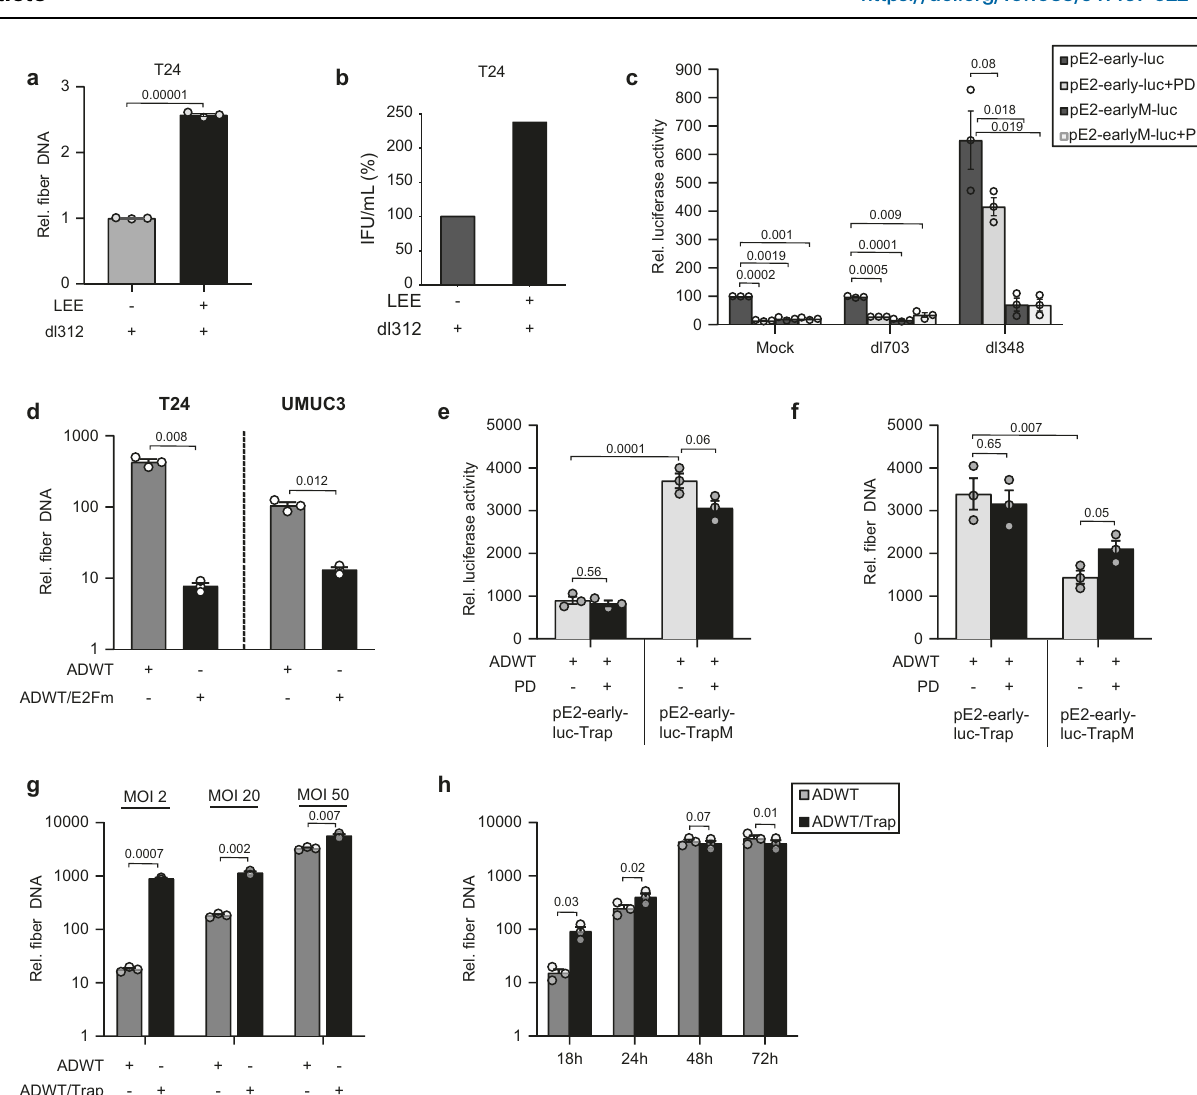
containing 10 E2-earlymotifs with 20E2Fbinding sites (pE2-early-luc-Trap) or with mutated E2F binding sites (pE2-early-luc-TrapM). Cells were infected with ADWT (MOI 50). Luciferase activity ( e ) (mean±SE) and viral replication ( f ) were assessed at 24hpi, n =3. g Viral genome replication was analyzed at 24hpi in T24 cells infected with ADWT or ADWT/Trap at indicated MOI, n =3. h T24 cells were infected with ADWT or ADWT/Trap (MOI 10) and viral genome replication was analyzed at indicated time points, n =3. All the viral replication analyses were performedbyqPCRtoamplifyviral fi berDNA.Dataarerepresentedasrelative fi ber compared to fi ber DNA at 4hpi as baseline ( n =3, mean±SD). SD standard devia- tion, SE standard error,hpi hourspost infection, MOImultiplicity ofinfection. The statistical signi fi cance was determined by two-sided Student ’ s t -test; n number of biologically independent samples. Source data are provided as a Source Data fi